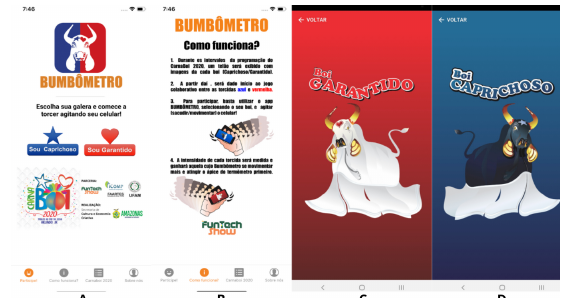
Figure 2. Screens of the Bumbometer app´s mobile client module, available for both Android and iOS